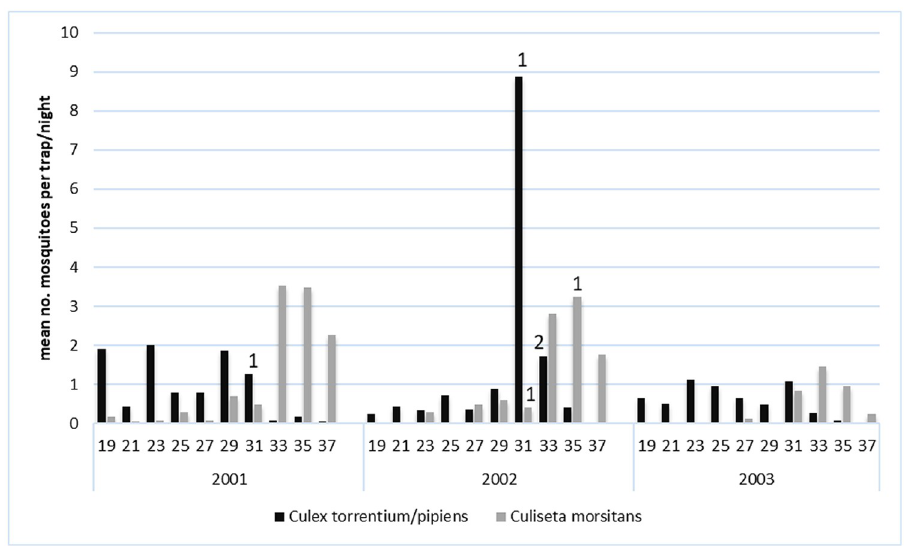
Fig 4. Temporal occurrence of the enzootic vectors Culex torrentium/pipiens and Culiseta morsitans , and of Sindbis virus isolated from these mosquitoes, during the summer seasons of 2001 to 2003 in the floodplains of River Dala¨lven, central Sweden. The bars refer to biweekly mosquito abundance and the numbers on top of bars refer to virus isolations.